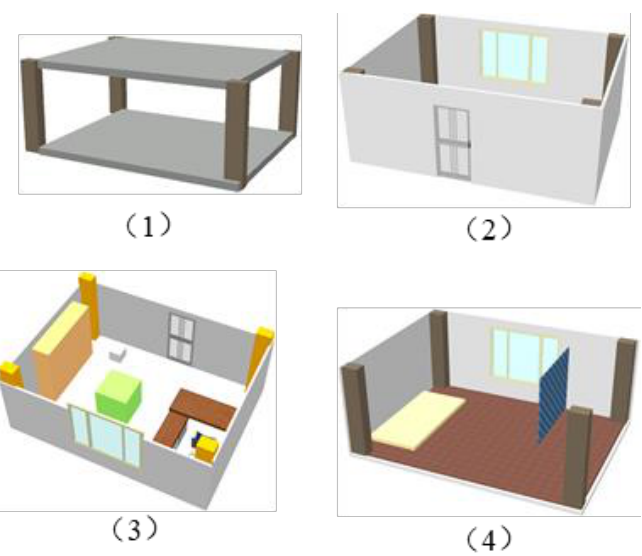
Figure 2. The four segmentation types of indoor space based on components (1 – 4).